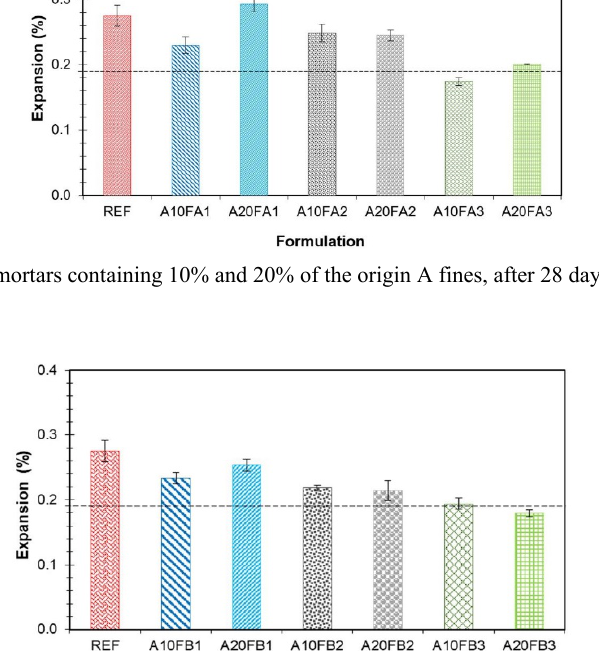
The FA1 fine addition (Figure 6) obtained a greater expansion reduction when added at the content of 10% than for the 20% fine addition content, because the mortar A20FA1 obtained the same expansion as the reference mortar, this same effect was seen for the mortars with FB1 addition (Figure